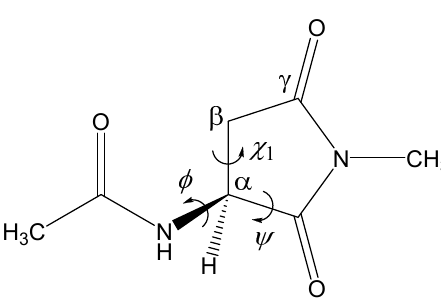
Figure 1. The model compound used in the present study (Ace–Asu–Nme, where Ace = acetyl, Asu = aminosuccinyl, and Nme = NCH 3 ). The φ (C–N–C α –C) and ψ (N–C α –C–N) dihedral angles which characterize the main-chain conformation, and the χ 1 dihedral angle (N–C α –C β –C γ ) which characterizes the side-chain conformation are indicated. The Asu residue is in the L -configuration.